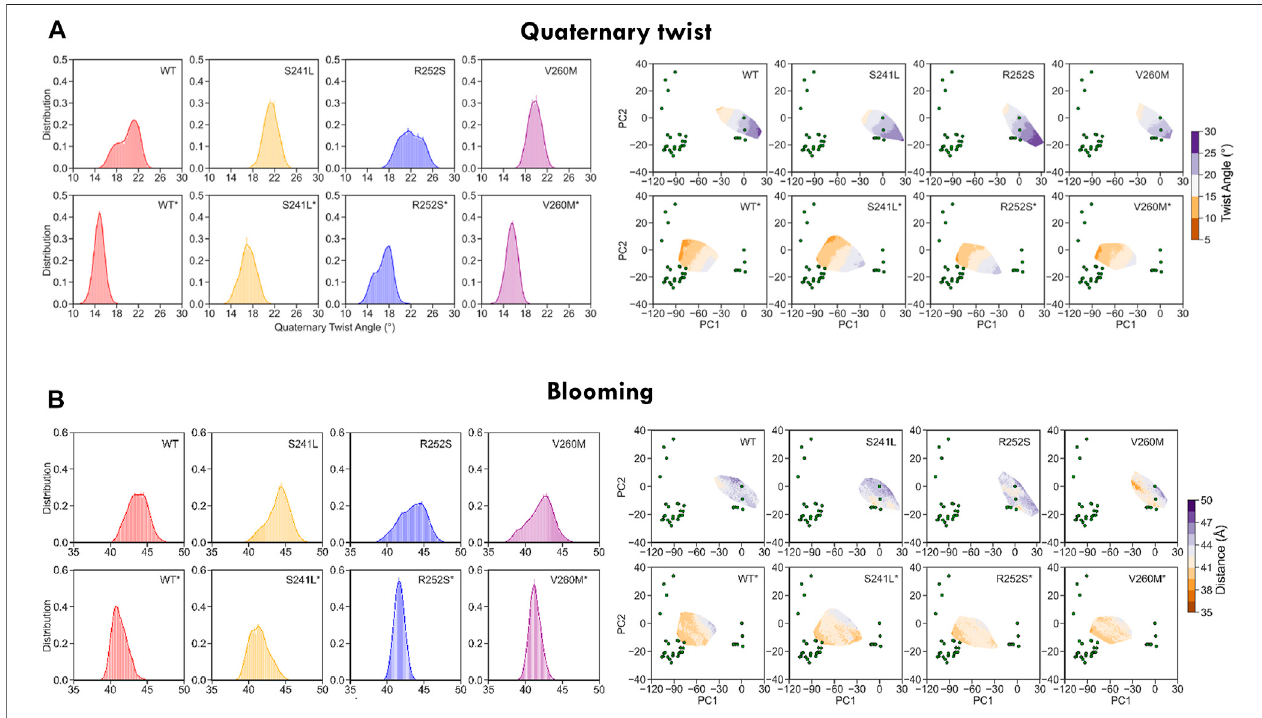
FIGURE5| WTand mutant GlyRglobalECDdynamicsfrom 1.2usmeta-trajectories. (A) GlobalECD-TMDquaternarytwist angle and (B) blooming. Note thatthe most global descriptor of channel status, quaternary twist, preserves a clear gradient-like pattern across the PC1-2 space both in WT and mutant simulations. See average values in Supplementary Table S3